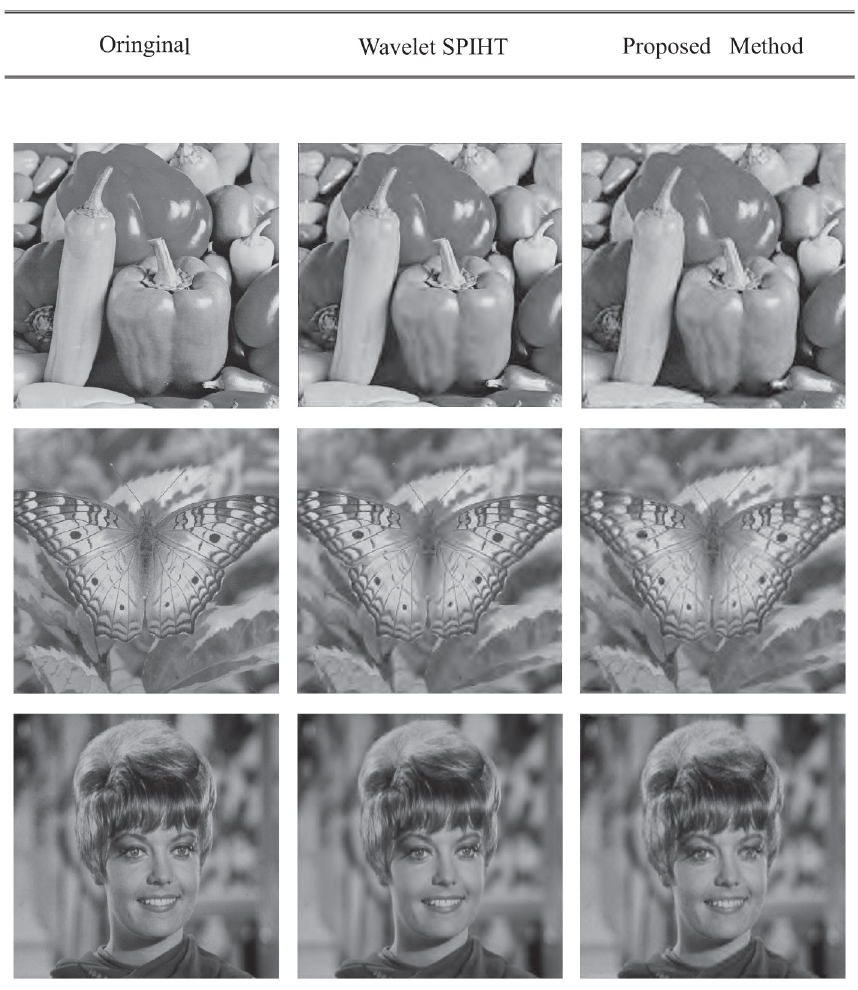
Fig 14. Visual comparisons between contourlet-HMM–PCNN SPIHT and wavelet SPIHT coding performances. Reprinted from [40] and [53] under a CC BY license, with permission from IEEE publisher, original copyright 2019, OSA publisher, original copyright 2014, respectively.